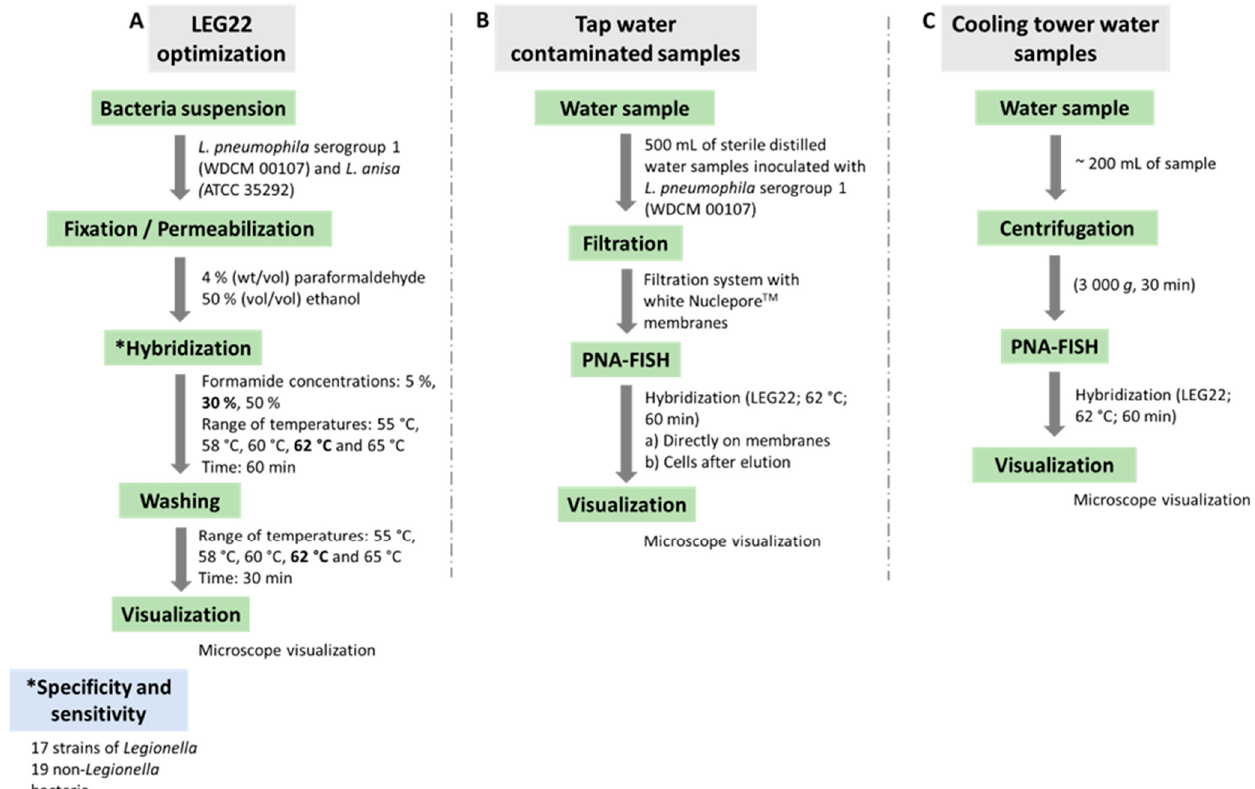
Figure 2. Representative diagram of the methodology used in the present study. ( A ) Optimization of LEG22 probe. Numbers in bold correspond to the selected parameters. Specificity and sensitivity were assessed subsequentely; ( B , C ) Application of PNA ‐ FISH method in tap ‐ water ‐ contaminated samples and in cooling tower water samples, respectively.